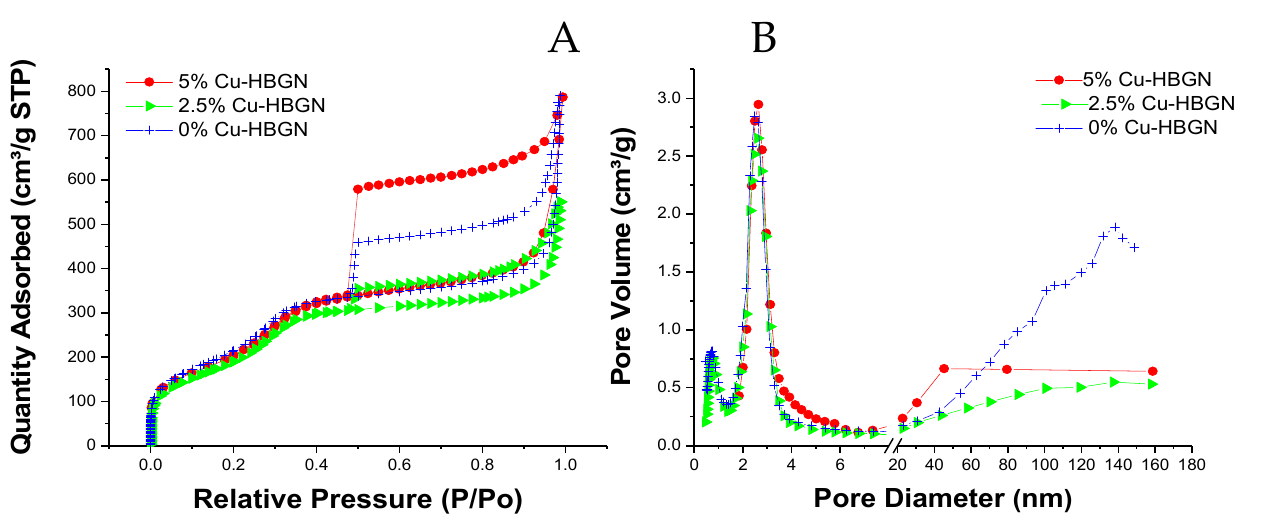
Figure 2. ( A ) Nitrogen adsorption-desorption isotherms and ( B ) pore size distribution of 0, 2.5 and 5% Cu-HBGN.